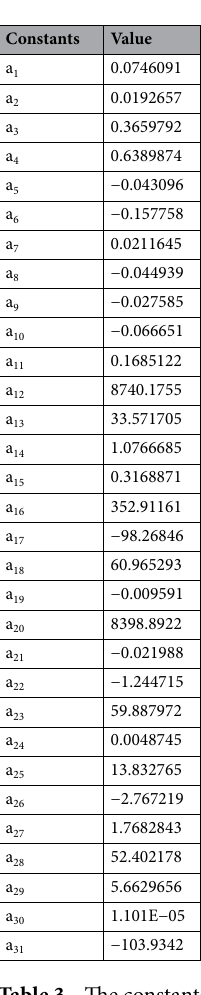
Table 3. The constants of developed